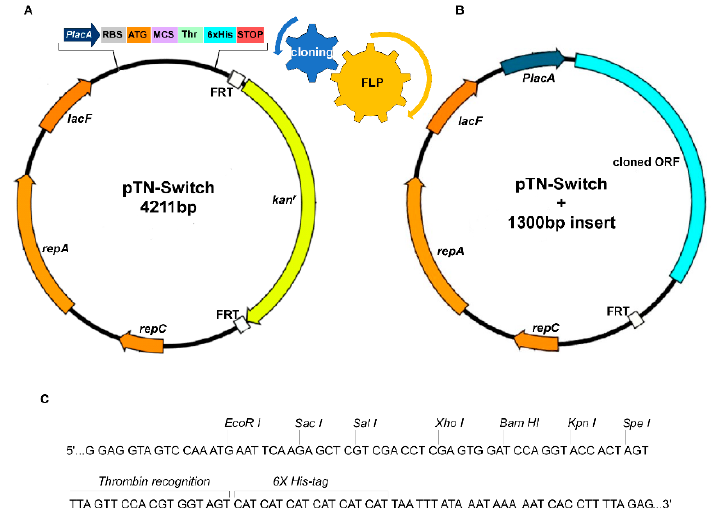
Figure 1. A map of pTN-Switch vector for improved cloning and food grade production. ( A ) The map shows the features of pTN-Switch including the array of functional elements in the MCS and the removable Km R cassette, flanked by FRT sites; ( B ) map of recombinant pTN-Switch after cloning a DNA fragment and Km R cassette excision by flippase; ( C ) the MCS of pTN-Switch vector enabling easy cloning, expression, and purification of recombinant proteins.